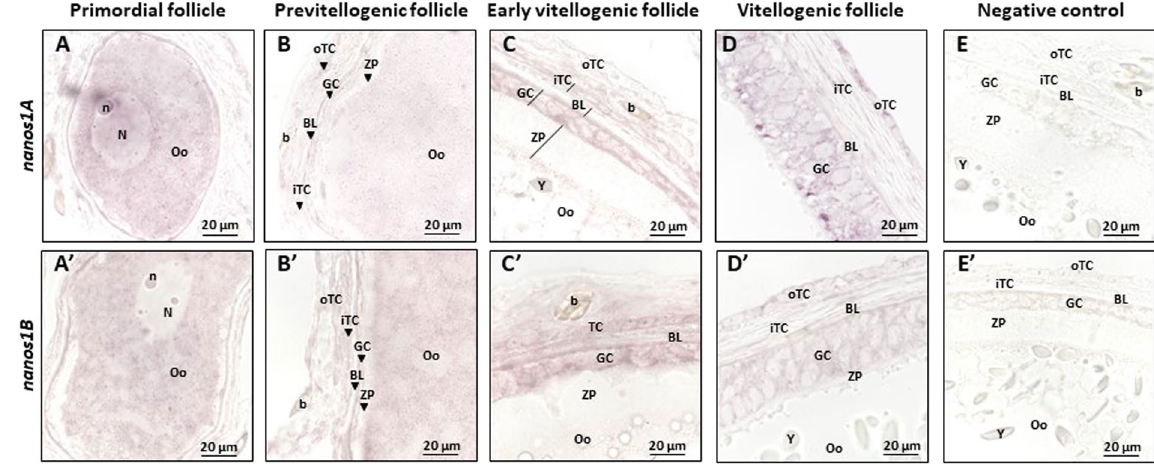
Figure 7. Similar distribution of nanos1A and nanos1B transcripts in germ cells and in follicular cells in dogfish ovary. The localization of nanos1 mRNAs was determined in ovaries by in situ hybridization using antisense digoxigenin-conjugated riboprobes directed against nanos1A ( A–D ) or nanos1B transcripts (A’–D’). E and E’ represent results obtained with sense riboprobes for nanos1A and nanos1B respectively. The nanos1A transcripts were detected in primary oocyte of primordial follicles (around 100 µ m in Ø illustrated in A). This labelling progressively decreased during oocyte growth until being undetectable in previtellogenic follicles (around 300 µ m in Ø illustrated in ( B ). The mRNAs were also detected in the granulosa cells (GC) and the outer theca cells (oTC) of early ( C ) and the more advanced ( D ) vitellogenic follicles (around 500 µ m and > 2 mm in Ø respectively). The same expression profile was detected for nanos1B with an expression in primary oocyte of primordial follicles (A’), in granulosa (GC) and outer theca cells (oTC) of early ( C ) and more advanced ( D ) vitellogenic follicles. In previtellogenic follicle (B’), nanos1B was still detectable in oocyte cytoplasm. b: blood cells, BL: basal lamina, GC: granulosa cells, N: nucleus, n: nucleolus, Oo: primary oocyte, TC: theca cells, iTC: inner theca cells, oTC: outer theca cells, Y: yolk, ZP: zona